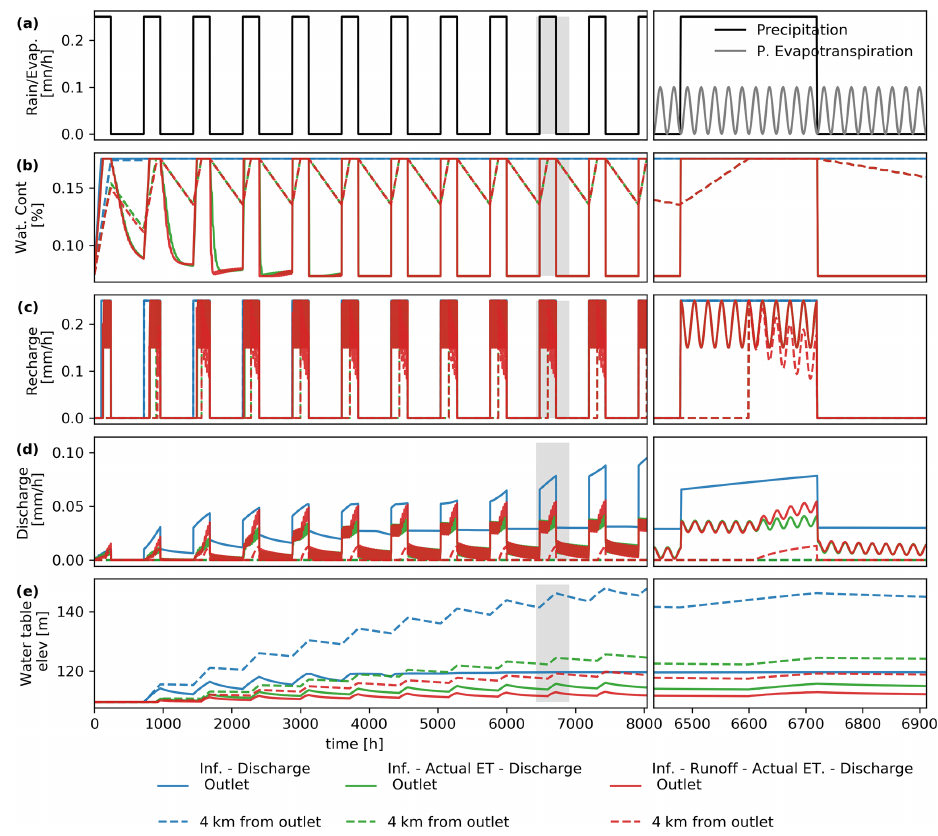
Figure 7. Temporal variation in (a) precipitation (black line) and evapotranspiration (grey line), (b) water content of the unsaturated zone, (c) groundwater recharge, (d) runoff/discharge, and (e) water table elevations. The right panels represent zoomed-in sections of the shaded areas in the left panels. Solid lines represent the variation at the catchment outlet, whereas dashed lines represent the temporal variation in the stream at a distance of 4km from the catchment outlet. For panels (b) – (e) , blue lines represent the “infiltration–discharge” scenario, green lines represent the “infiltration–evapotranspiration–discharge” scenario, and red lines represent “infiltration–runoff–evapotranspiration– discharge”